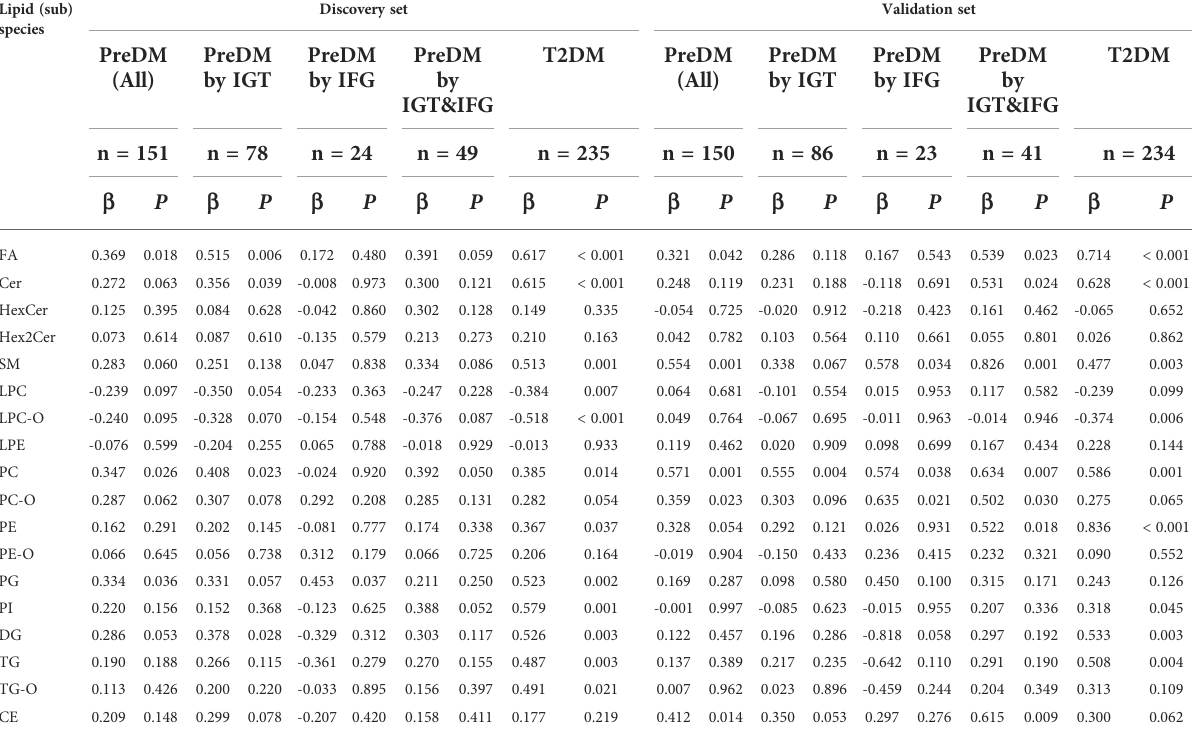
66%) was much higher than FPG alone (48.3% and 42.7%) in identifying patients with PreDM from NC in the discovery and validation sets. Notably, the combination of lipid panel 1 with age, sex, BMI and FPG exhibited more improvement in diagnosing PreDM in the discovery and validation sets (diagnostic accuracy = 77.3% and 73.2%), respectively (Table 4). For the diagnosis of T2DM, the panel 2 combined with FPG had a similar AUC to that of FPG (i.e., 0.986 and 0.964 versus 0.982 and 0.951) in the discovery and validation sets, respectively (Table 4). However, this serum lipid panel 2 combined with FPG showed better diagnostic accuracy when compared with FPG (92.3% versus 68.1%, and 88.9% versus 59.0% in the discovery and validation sets) in identifying patients with T2DM from NC. Furthermore, the combination of this lipid panel 2 with age, sex, BMI and FPG had an even more accuracy in diagnosing T2DM (accuracy = 93.2% and 94.0% in the discovery and validation sets) (Table 4). Additionally, similar results were obtained when using the American Diabetes Association (ADA) criteria which de fi nes IFG as 5.6 to 6.9 mmol/L (Table 4). To assess whether the panel 1 and the panel 2 have the ability to identify the risk of diabetes, the risk probability of developing into diabetes was calculated by an equation constructed from the above two panels of 7 lipid markers (i.e., FA 18:2, FA 20:2, SM 32:1, SM 40:7, PC 32:0, PC 38:7 and PC 40:6), age, BMI and FPG.